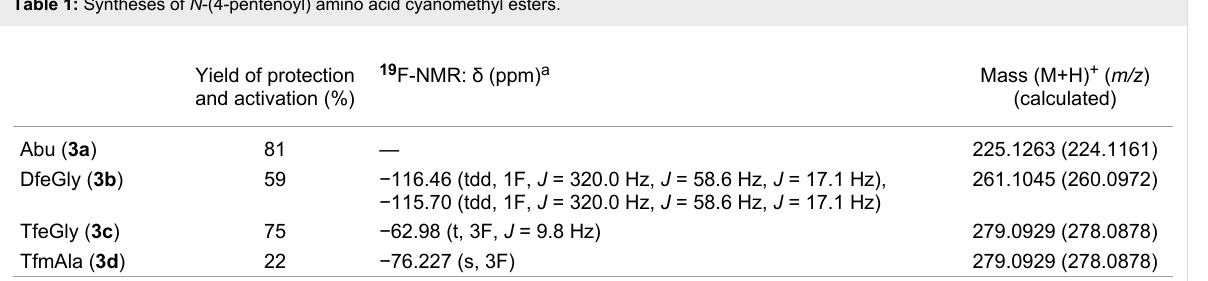
Table 1: Syntheses of N -(4-pentenoyl) amino acid cyanomethyl esters.